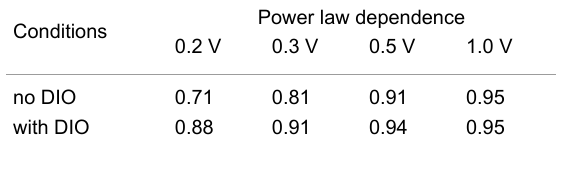
Table 2: Power law dependences of photocurrent on light intensity at specific effective voltages for BHJ devices from Figure